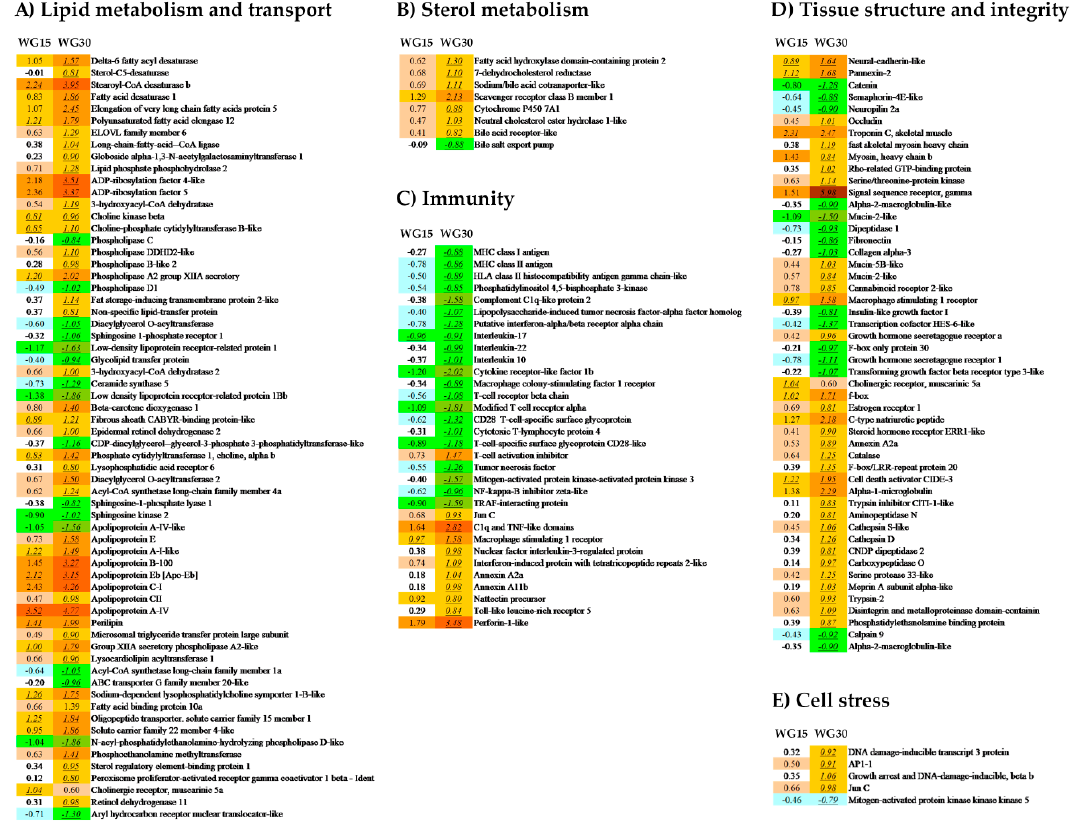
Figure 2. Major differentially expressed genes (DEGs) in the intestine of salmon fed with WG containing diets; genes are related to ( A ) lipid metabolism and transport, ( B ) sterol metabolism, ( C ) immunity, ( D ) tissue structure and integrity, ( E ) cell stress. Data are folds to the FM-fed control group, DEGs (>1.754-fold, p < 0.05) are indicated with underlined italics.